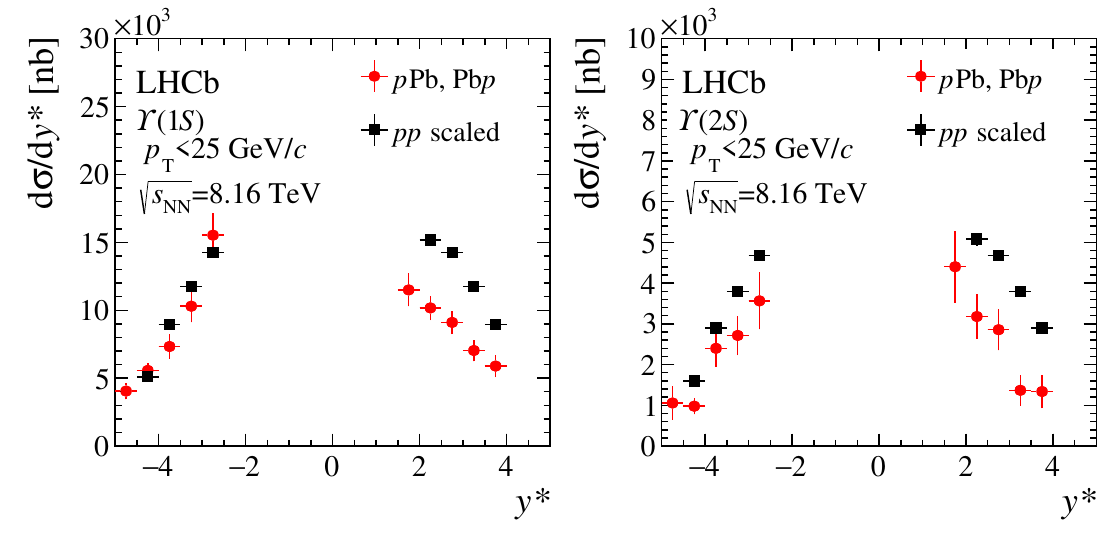
Figure 4 . Cross-section of (left) (cid:7) (1 S ) and (right) (cid:7) (2 S ) production as a function of y (cid:3) integrated over p T for the backward (negative y (cid:3) ) and forward (positive y (cid:3) ) samples, compared to the cross- p section measured in pp , interpolated to s = 8 : 16 TeV. In this and subsequent (cid:12)gures, the NN uncertainties shown are the sums in quadrature of the statistical and systematic components.